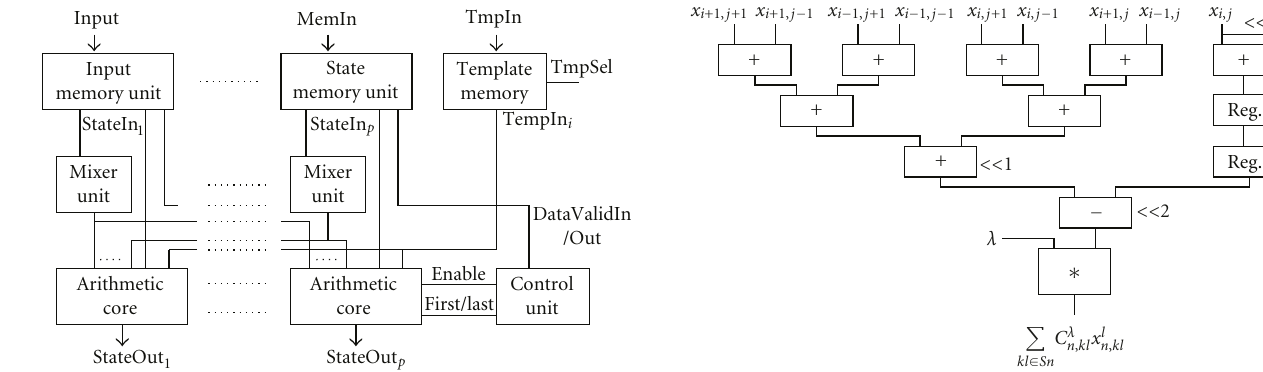
Figure 2: The structure of the optimized multilayer Falcon-ML architecture ( p denotes the number of layers).